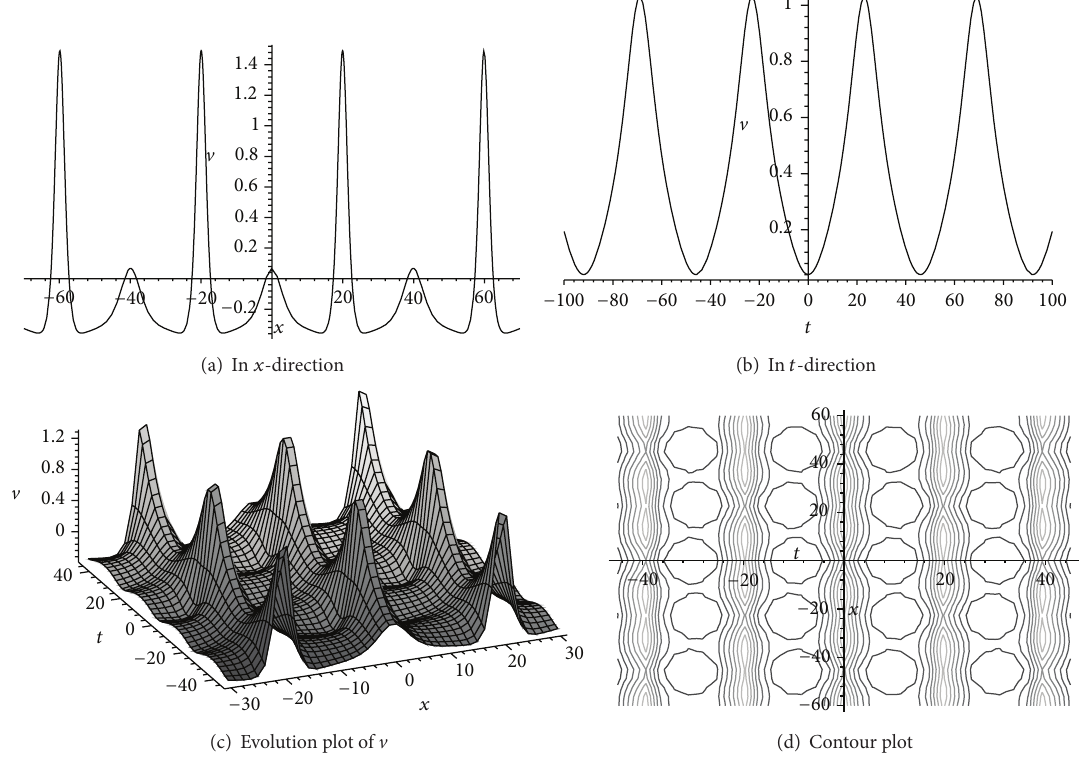
Figure 2: Doubly periodic wave solution V (𝑥, 𝑡) given by (21) with 𝛿 = 0.2 , 𝛽 = 0.4 , 𝜆 = 0.2 , 𝑘 = 0.8 , and 𝑘 1 = 0.2